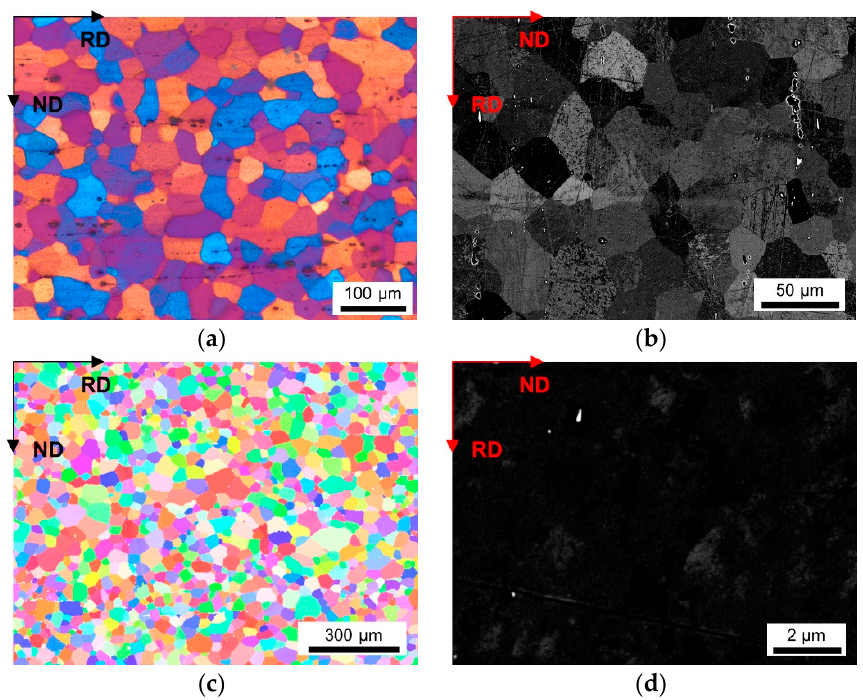
Figure A4. Microstructure of the soft annealed LFe-LMn cast under S-C condition, homogenized at 550 °C and cold rolled to a CRD of 35%. ( a ) LOM. ( b ) BSE image. ( c ) EBSD IPF map in RD–ND plane. ( d ) BSE micrograph showing dispersoids.